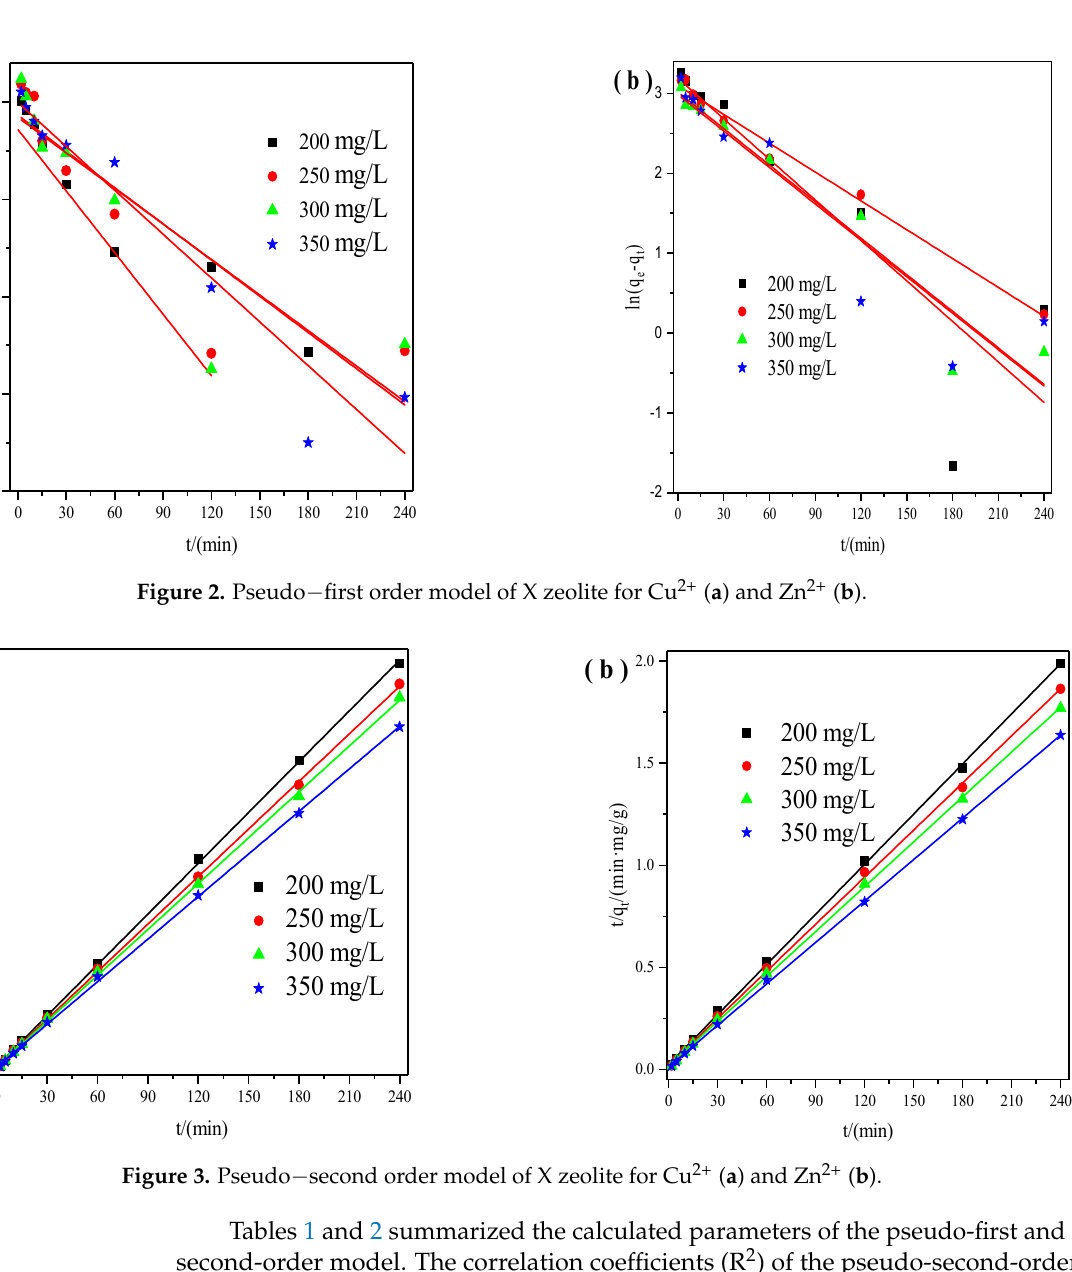
Figure 2. Pseudo − first order model of X zeolite for Cu 2+ ( a ) and Zn 2+ ( b ). The pseudo − second order model was displayed in the following format [31]: